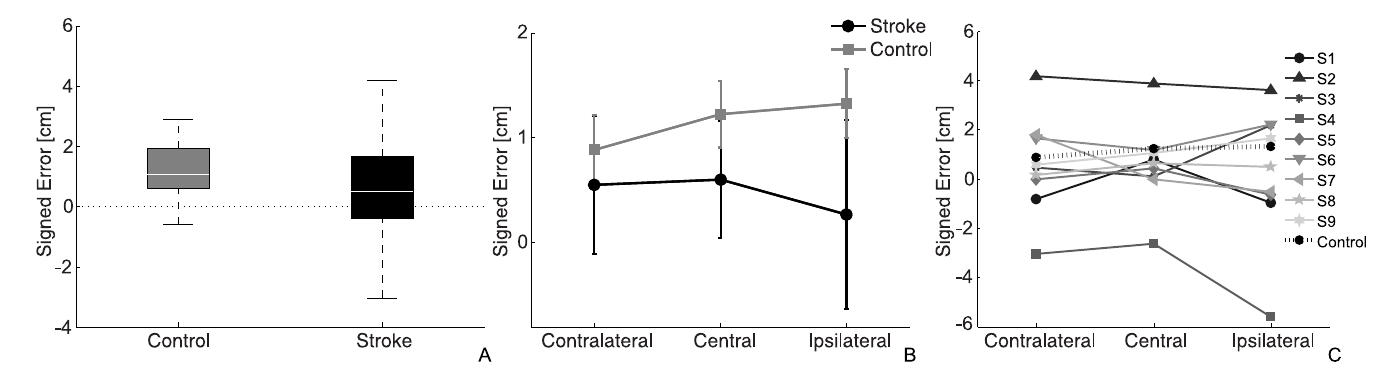
Fig 3. Signed errors. (A) Box-plot of signed errors for the two groups. (B) Mean signed errors in the 3 directions for the two groups, where the gray squares represent data from the control group and black circles represent stroke patients. (C) Signederrors for each patient and mean value of the control subjects.